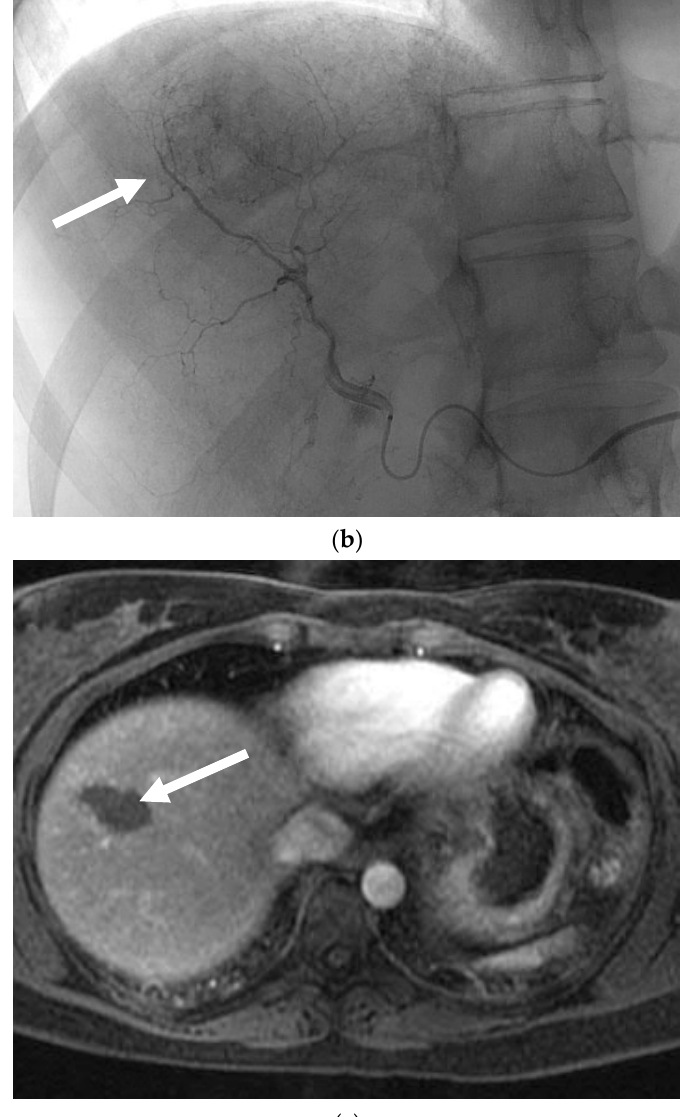
Figure 3. Hepatic adenoma following embolization. ( a ) MRI with gadolinium shows an enhancing 4.3 cm lesion in segment 8 (solid white arrow). This was symptomatic and had increased in size over the past year. ( b ) Selective injection of the right hepatic artery demonstrating the hypervascular hepatic adenoma (solid white arrow). This was treated with 40–100 µ m and 100–300 µ m tris-acryl gelatin microspheres. ( c ) Three months following embolization, MRI with contrast shows complete necrosis of the adenoma with interval decrease in size (solid white